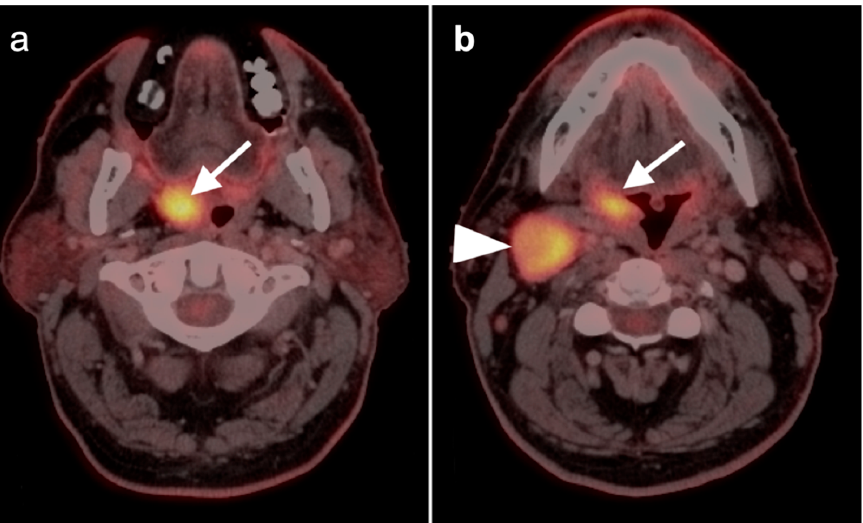
Figure 13. Right tonsillar oropharyngeal squamous cell carcinoma. ( a ) A right palatine tonsillar hypermetabolic squamous cell carcinoma (white arrows). ( b ) There is an enlarged hypermetabolic right level 2 cervical lymph node consistent with tumor involvement (( b ), white arrowhead).